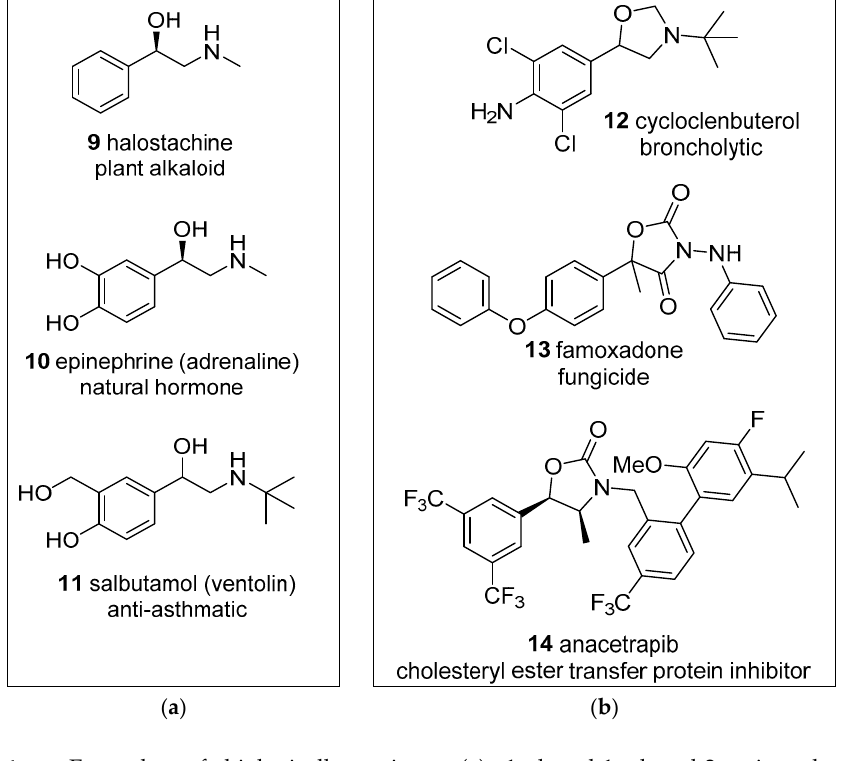
Figure 1. Examples of biologically active: ( a ) 1-phenyl-1-ethanol-2-amine derivatives; ( b ) oxazolidine derivatives.